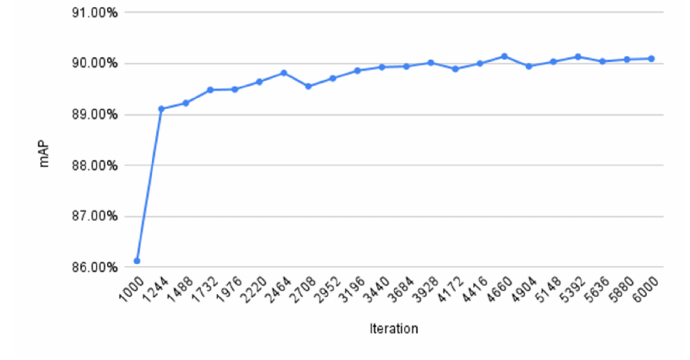
Fig. 2 Average mAP of all laptop dataset experimental repetitions